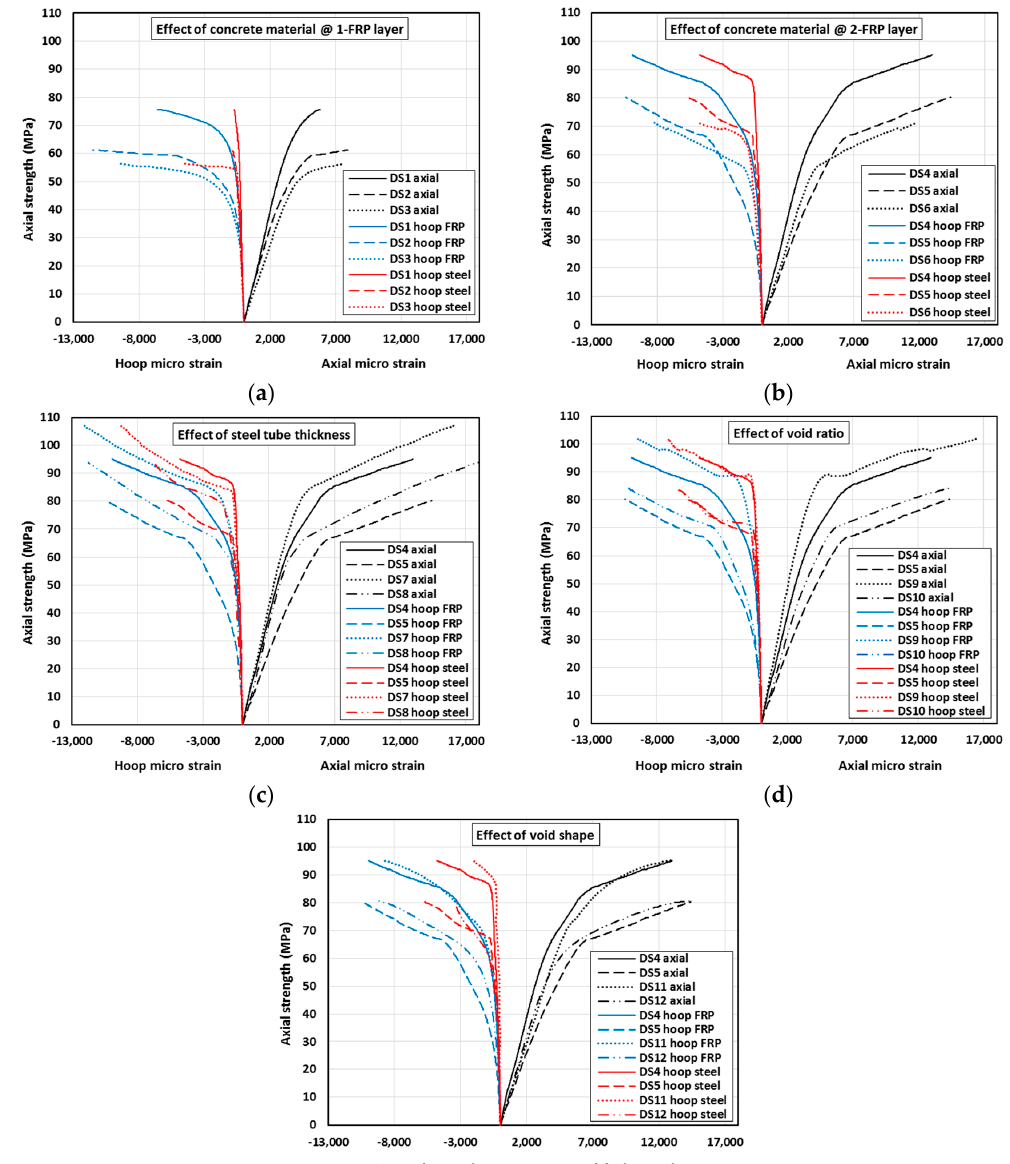
Figure 6. Axial and hoop stress–strain relationships: ( a ) Effect of concrete material at 1-FRP layer, ( b ) effect of concrete material at 2-FRP layer, ( c ) effect of steel tube thickness, ( d ) effect of void ratio, and ( e ) effect of void shape.